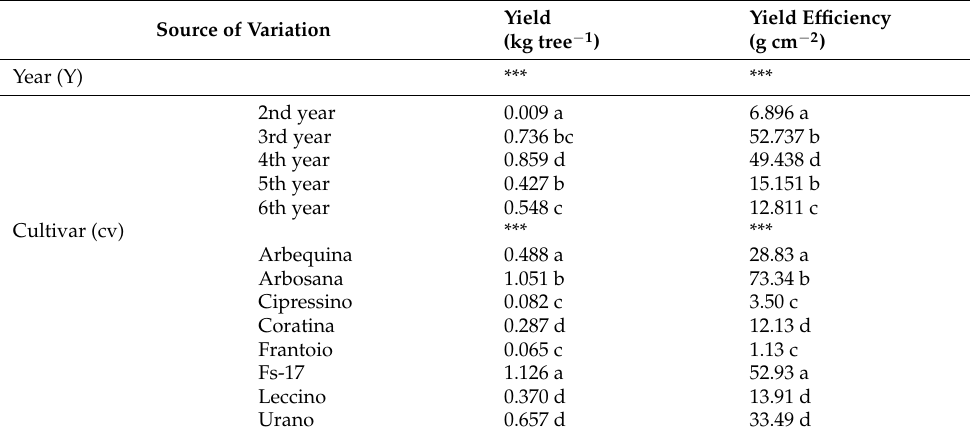
Table 2. Matrix correlation (Person correlation) among growth parameters of all cultivars. p -values: *** p < 0.001.